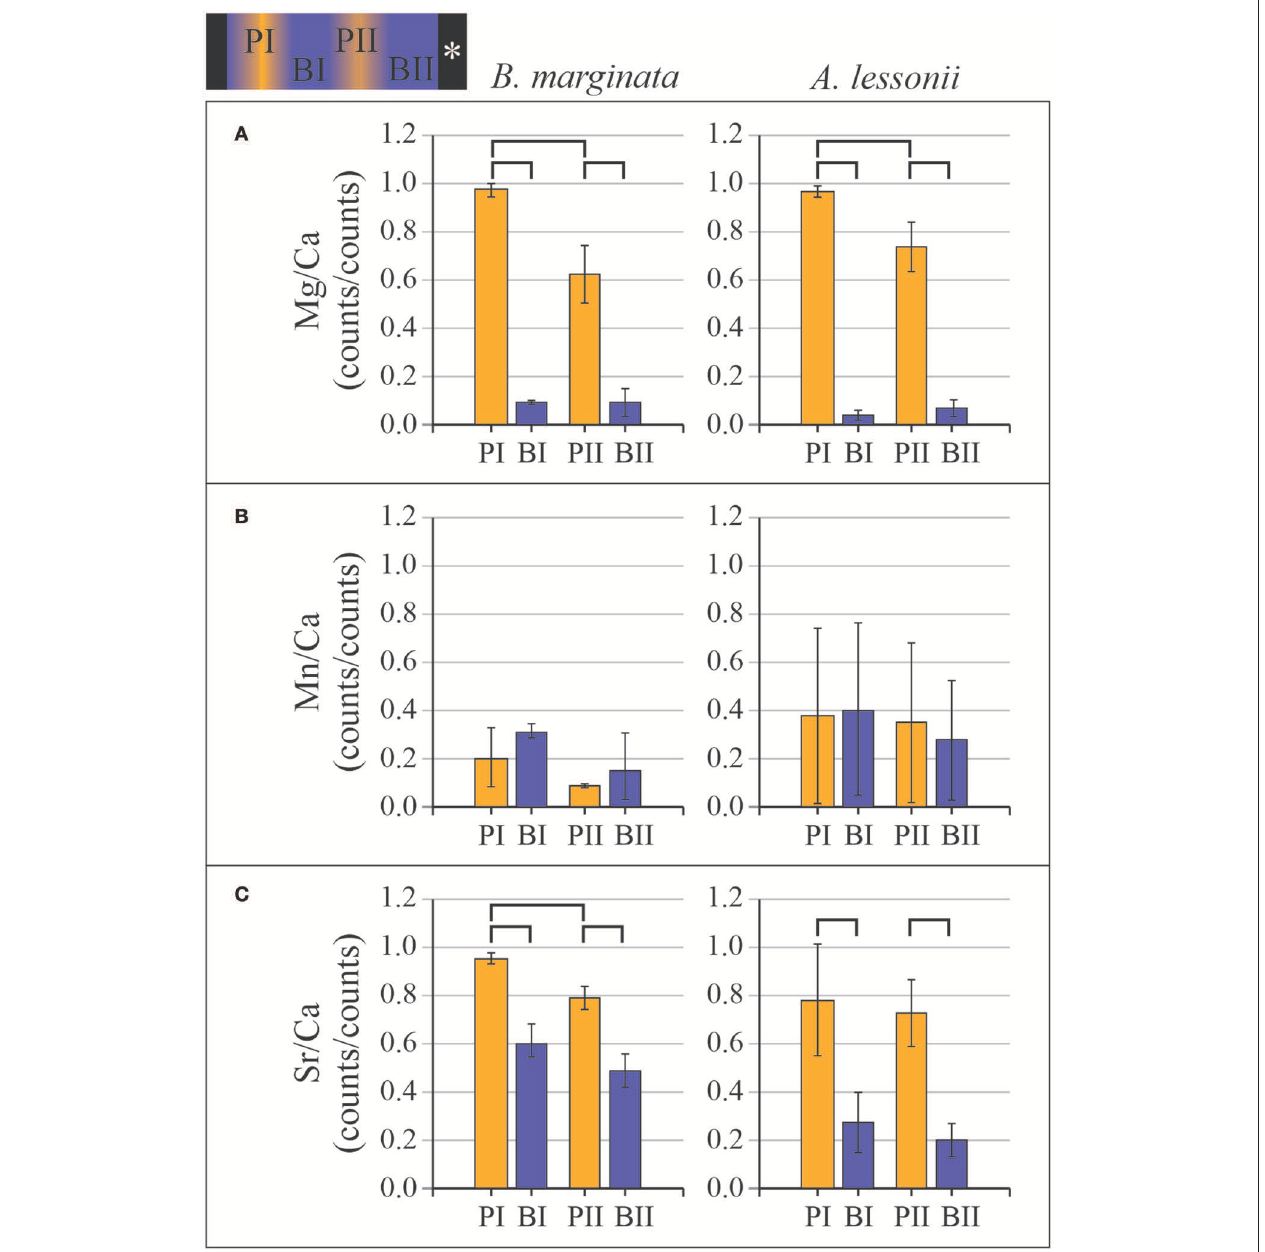
FIGURE 9 | Normalized average values of primary peak and base (PI and BI) and secondary peak and base (PII and BII) for the two species Bulimina marginata (left panels) and Amphistegina lessonii (right panels) from Aq10 for (A) Mg/Ca, (B) Sr/Ca, and (C) Mn/Ca derived from profiles obtained by nanoSIMS analysis (for example, see Figure 8 ). The top shows a hypothetical transect map with locations of PI, BI, PII, and BII, with the asterisk indicating the outer part of the test. Note that peak-base data are in counts/counts, unlike semiquantitative EPMA data presented in Figures 6 , 7 . nanoSIMS, nanoscale secondary ion mass spectrometry; EPMA, electron probe